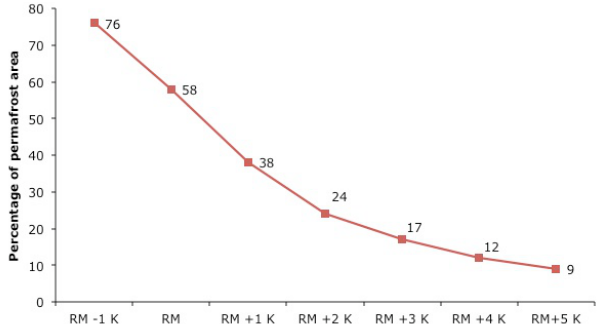
Fig. 4. Modelled percentage area underlain by permafrost under equilibrium conditions for the entire region under the climate mod- elling